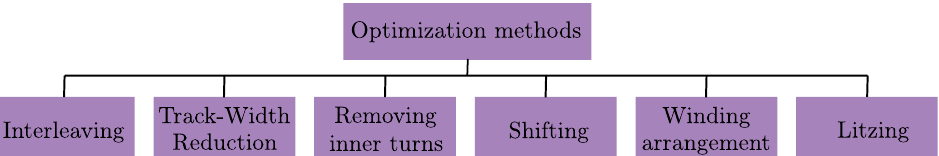
Figure 6. An overview of the optimization methods discussed in this paper. The following methods are described here: interleaving [50–53], track-width reduction [54–58], removing inner turns [59], shifting [17], changing the winding arrangement [17], and Litzing